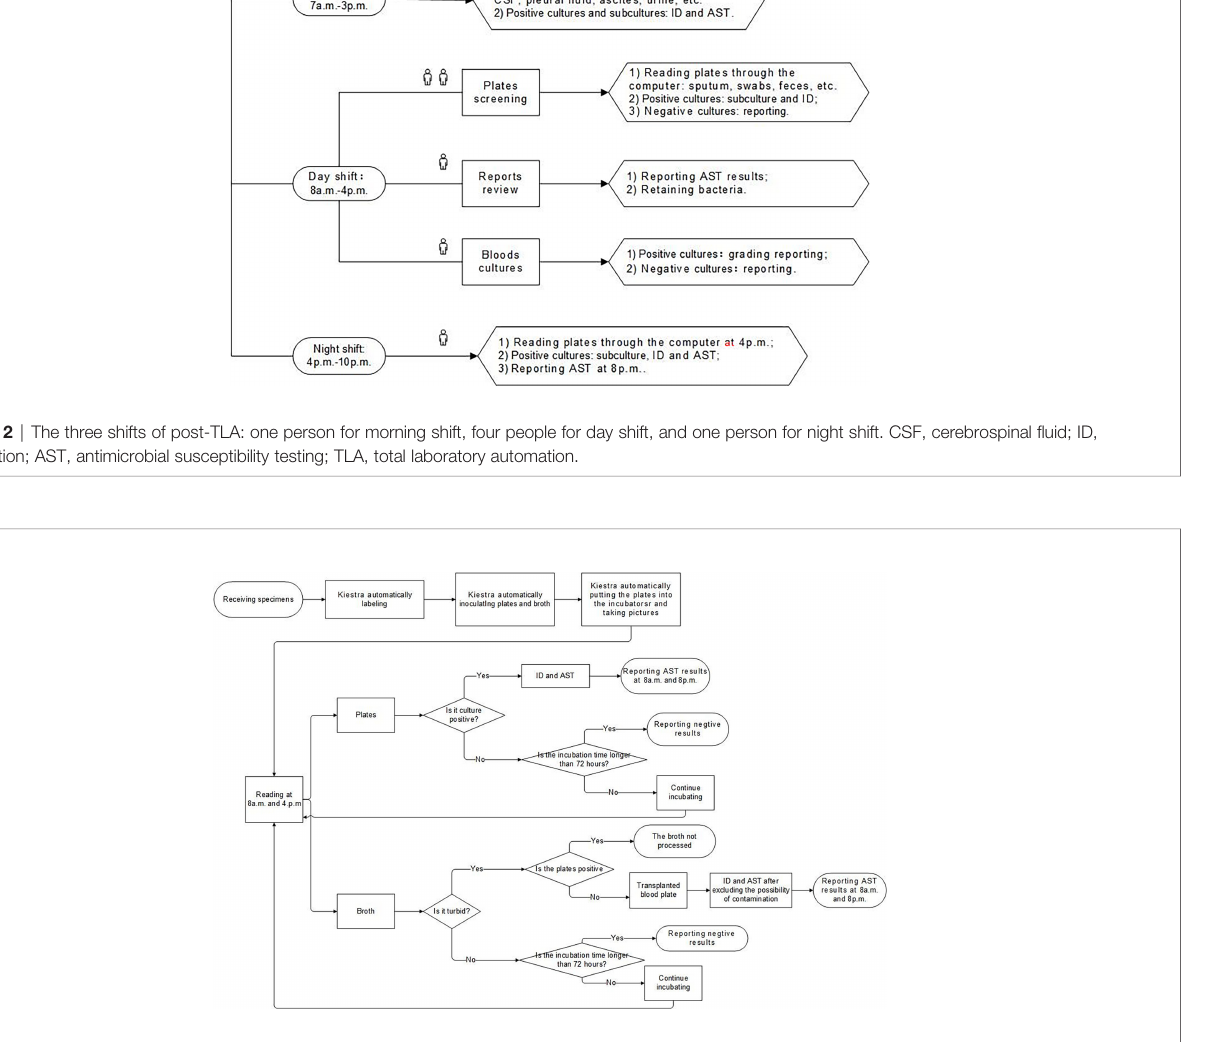
FIGURE 3 | The Laboratory process fl ow of CSF specimens. ID, identi fi cation; AST, antimicrobial susceptibility testing; CSF, cerebrospinal fl